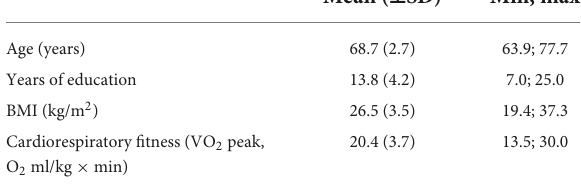
TABLE 1 Sample characteristics.